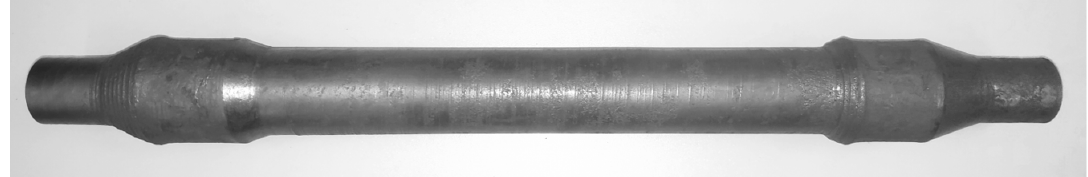
Figure 26. 1:5 scale railway axle (after removing allowance) that was skew rolled under laboratory conditions at the Lublin University of Technology.